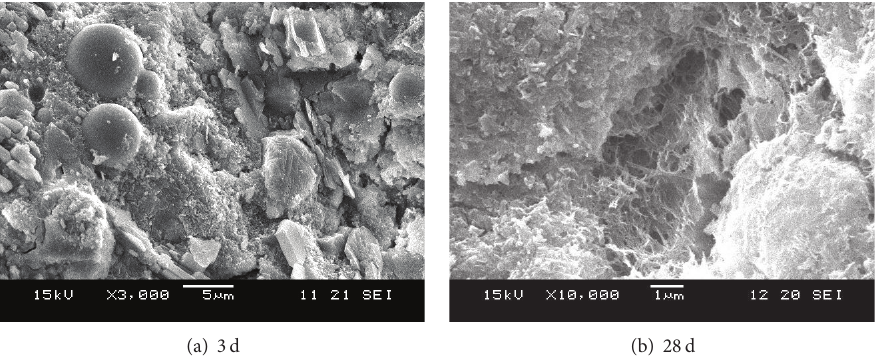
Figure 7: SEM images of gypsum-bauxite grouting mortar.